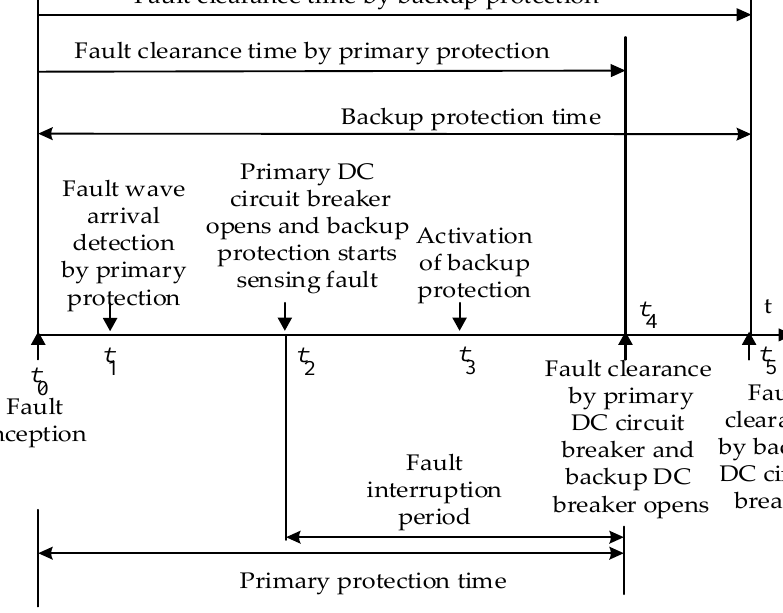
Figure 1. Timing diagram for a direct current (dc) grid protection.